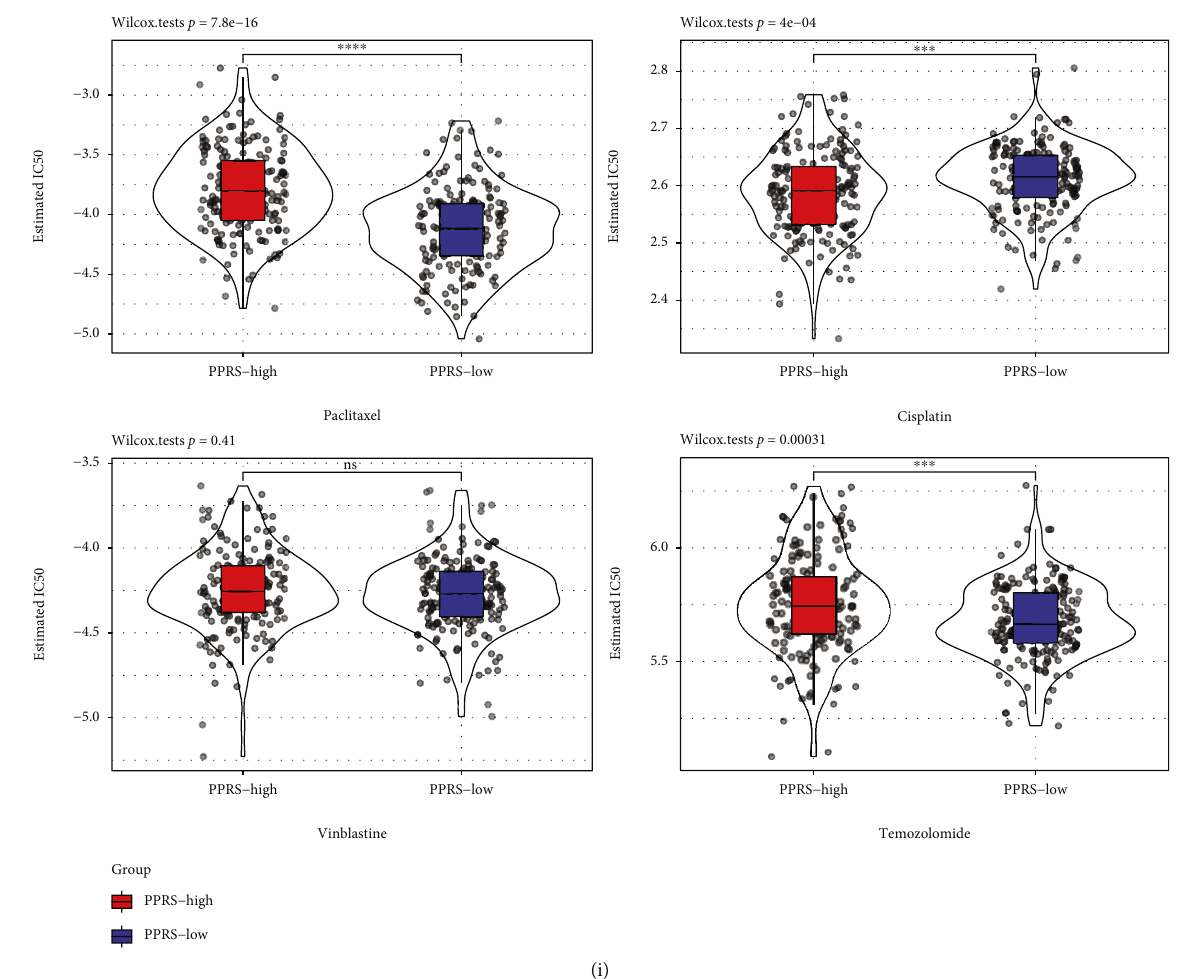
Figure 10: Diverse immunotherapeutic responses among melanoma samples from PPRS-high and PPRS-low groups. (a – d) IC levels within melanoma samples from TCGA-SKCM (a), GSE65904 (b), GSE54467 (c), and GSE22153 (d) cohorts with high and low PPRS scores. (e) A bar plot demonstrating frequencies of immune checkpoints upregulated in PPRS-low cancer patients across the four cohorts. The y -axis indicates the names of immune checkpoints, and the x -axis represents the number of cohort. (f) The boxplots indicate the average immunophenoscore values IPS across the two PPRS subgroups in SKCM tumors. Overall, PPRS-low tumors that could be treated with combined anti-PD-1 and anti-CTLA-4 checkpoint blockade or with anti-PD-1 alone had signi fi cantly higher IPS, which is indicative of a better response to these immunotherapies. (g, h) The distribution of PPRS levels in samples responsive and resistant to treatment from GSE78220 (g) and GSE91061 (h) datasets and its performance in predicting samples prognosis. (i) Box plots exhibiting the estimated values of temozolomide, paclitaxel, and cisplatin within melanoma samples from TCGA-SKCM dataset with high and low PPRS IC 50